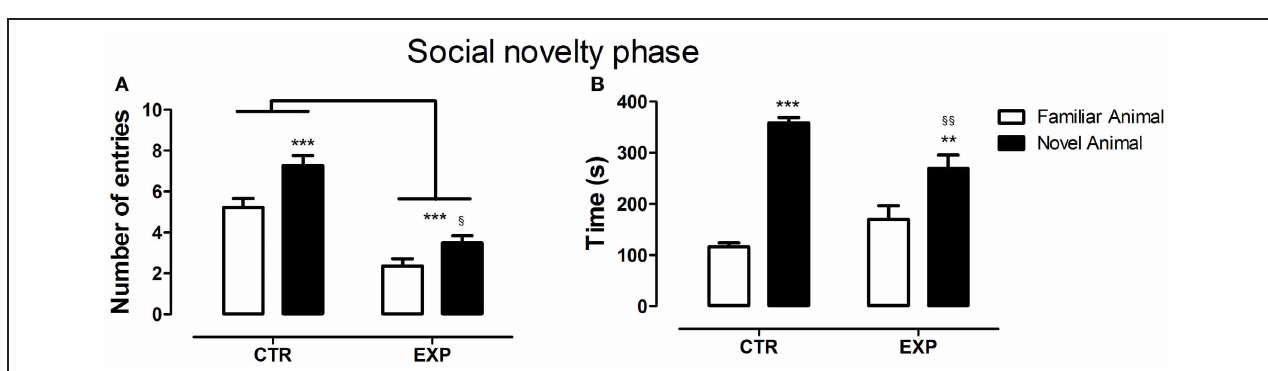
FIGURE 2 | Number of entries (A) and time spent (B) into social (rat) and non-social (object) compartments is shown as mean ± standard error. Control group (CTR) n = 14 and Experimental group